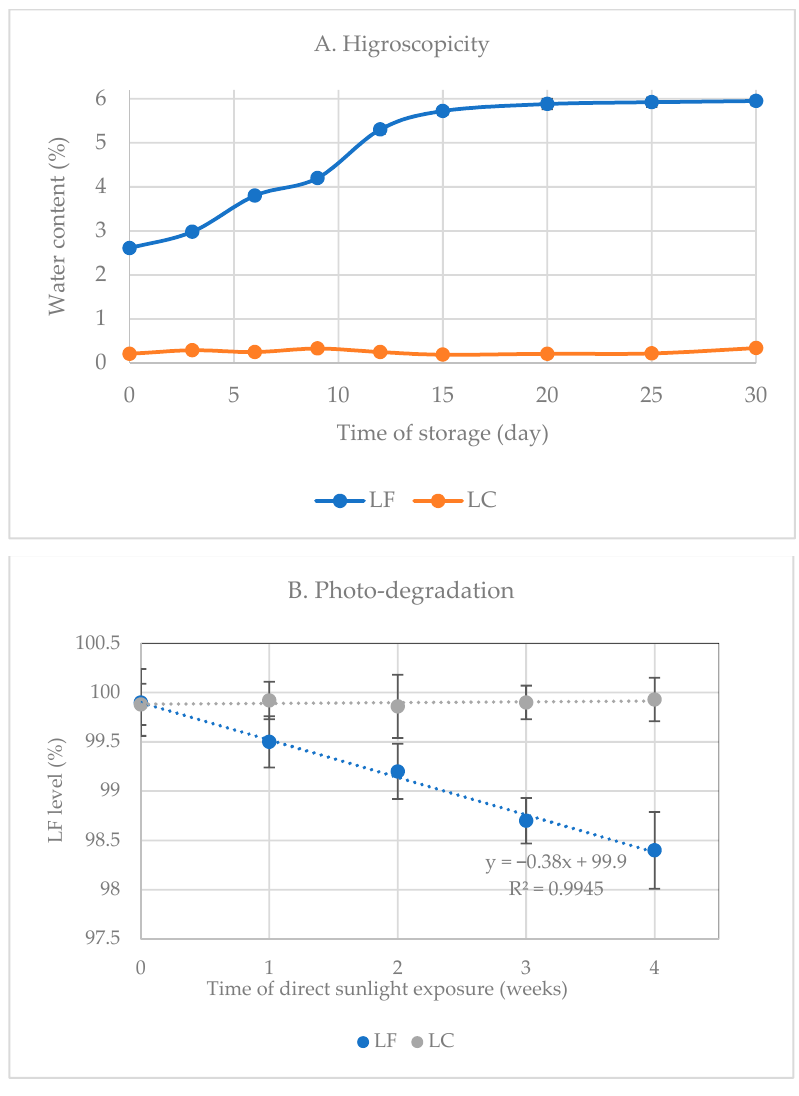
Figure 9. The curves of hygroscopicity test data ( A ) and photo-degradation curve ( B ) of levofloxacin (LF) and levofloxacin citrate (LC).